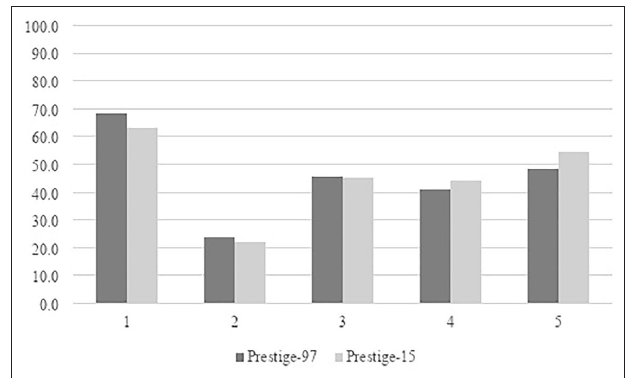
FIGURE 2 | Share of women in quintiles 1–5, 1997 and 2015 (percentage). Weighted LFS-data.